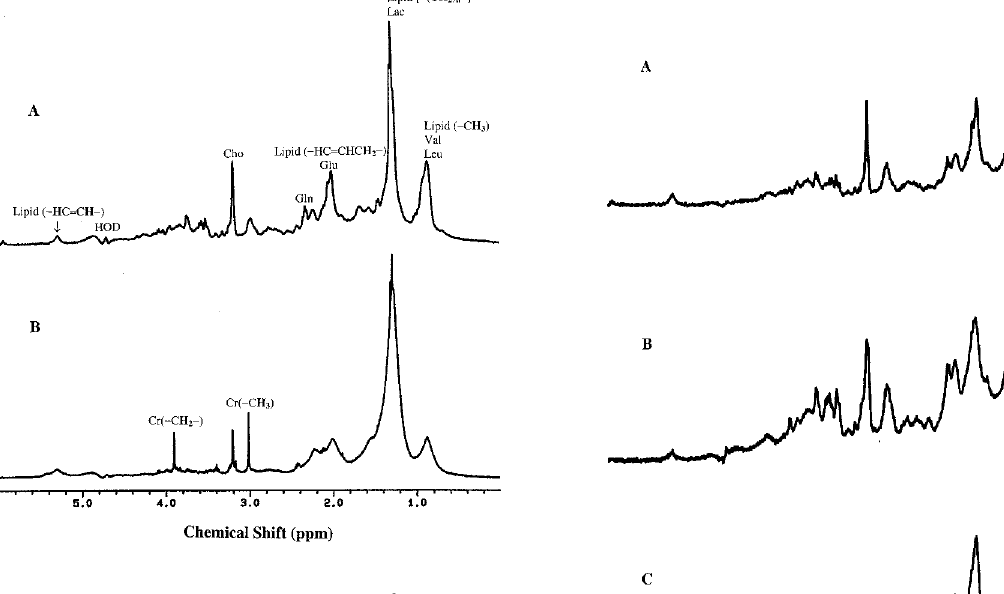
Fig. 1. Proton MR spectra (360 MHz, 25 ° C) of soft tissue specimens: (A) malignant (cid:142) brous histocytoma, (B) adjacent normal tissue from the same subject. Abbreviations: Chos, choline-containing compounds; Cr, creatines; Gln, glutamine; Glu, glutamic acid; HOD, deuteriated water; Leu, leucine;Val, valine. Assignments do not imply that these are the only substances contributing to a particular peak.